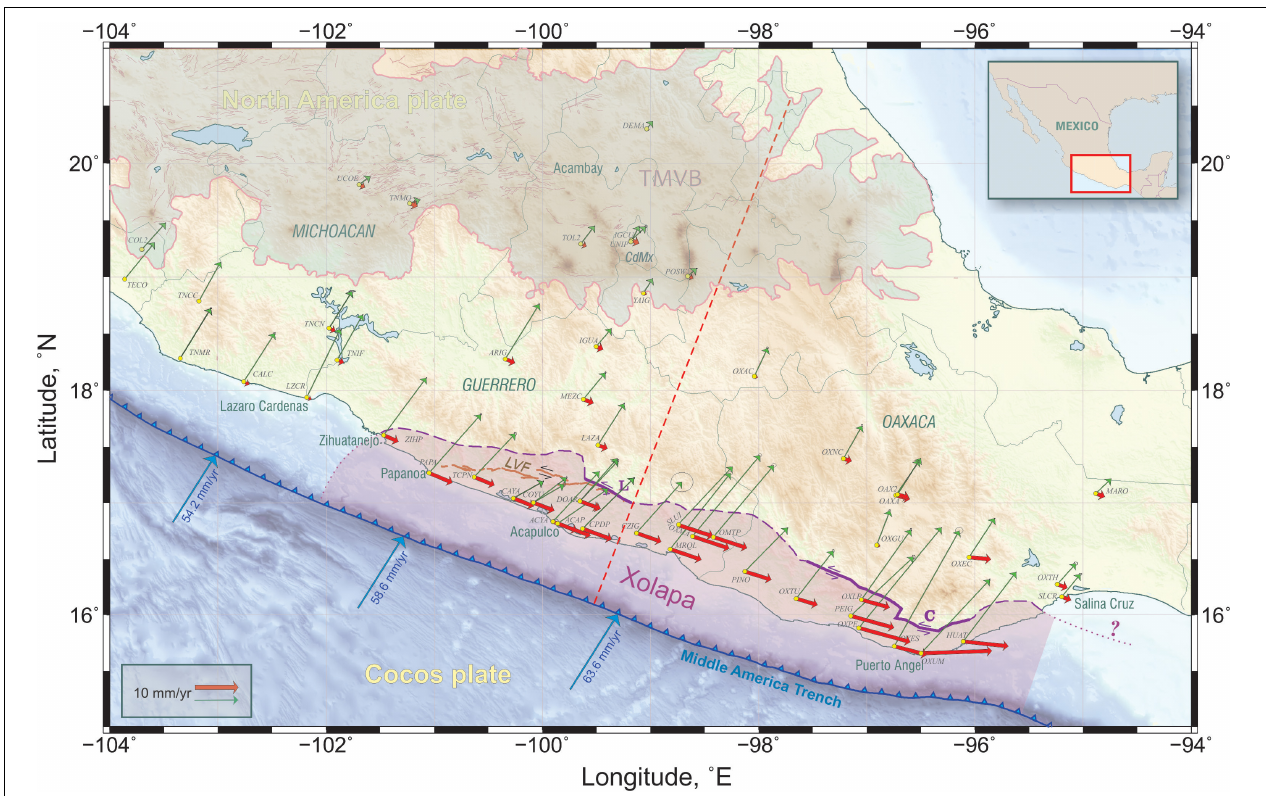
FIGURE 1 | The study area (Inset) and location of permanent GPS stations (small yellow circles). Secular GPS velocities (wrt North America plate, mm/year) are shown as green vectors, and red vectors are their oblique components (parallel to the MAT). The solid-dashed purple line delineates the La Venta–Chacalapa (LVC) fault zone according to Tolson (2005). L , La Venta segment (Solari et al., 2007). C , Chacalapa segment (Tolson, 2005). The segmented dark brown line is a trace of the LVF according to Gaidzik et al. (2016). An abrupt decrease of the secular oblique velocity is noticeable across the LVC fault zone (Ramírez-Herrera et al., 2018), which is roughly the northern border of the Xolapa allochthonous terraine (XOLAPA, shaded area located between the MAT and the LVC). Blue vectors are the Cocos–North America PVEL convergence velocities (DeMets et al., 2010) at the MAT. The red dashed line normal to the MAT specifies the horizontal axis of a cross-section shown in Figures 2 , 3 . The gray shaded region to the north of 19 ◦ N shows the Trans Mexican Volcanic Belt (TMVB) with a dense E–W extended fault cluster [adapted from Ferrari et al. (2012)]. The fault sequence mapped close to the Acambay area is the northern margin of the sliver proposed by Ego and Ansan